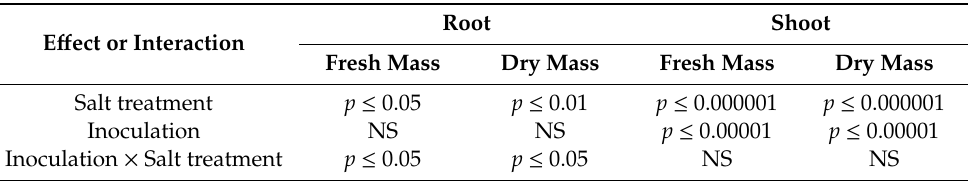
Table 2. Analysis of variance of fresh and dry mass of roots and shoots of wheat plants untreated with bacteria or inoculated with either B. subtilis IB-22 or P. mandelii IB-Ki14 (inoculation) grown in the presence and absence of NaCl (salt treatment). p values are presented for e ff ects of inoculation and salt-treatment and interaction of these factors (NS—non-significant). Root E ff ect or Interaction